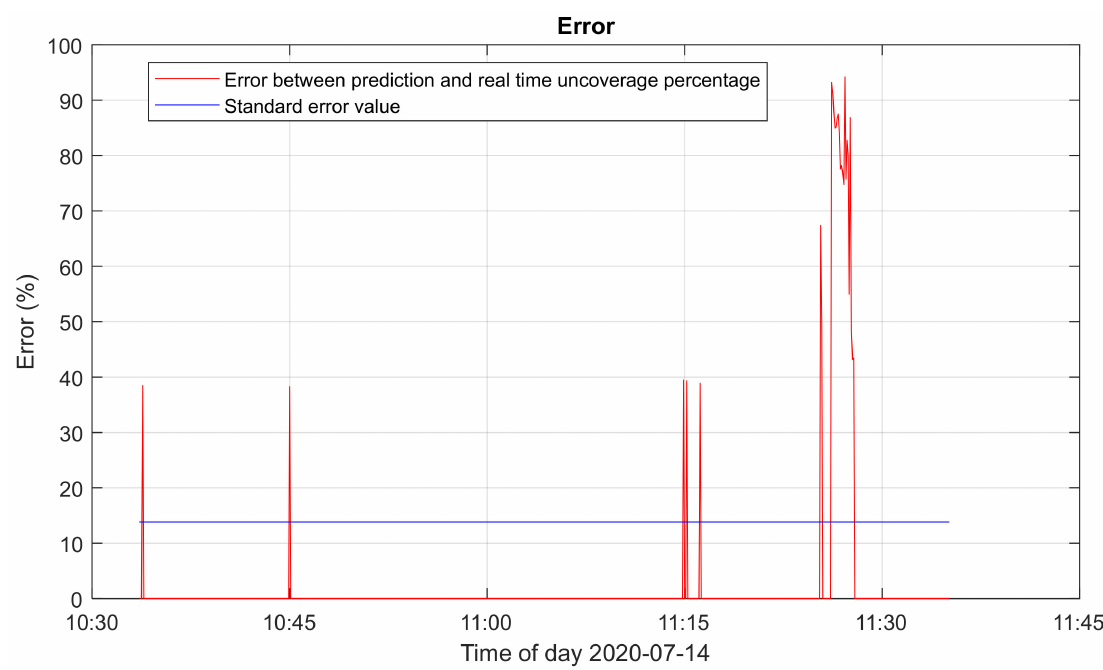
Figure 17. Error level between real-time and predicted level of sun un-coverage on 14 July 2020 from 10:30 until 11:45.